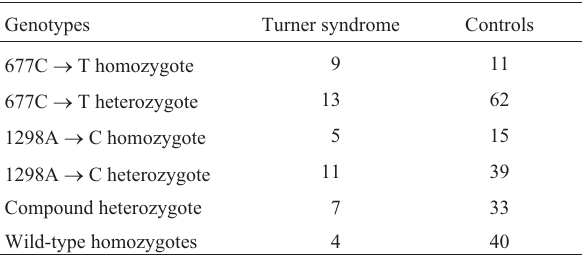
Table 2 - Genotypic distribution of the methylenetetrahydrofolate reductase (MTHFR) 677C (cid:1) T and 1298A (cid:1) C alleles in 49 individuals with Turner syndrome and 200 controls.